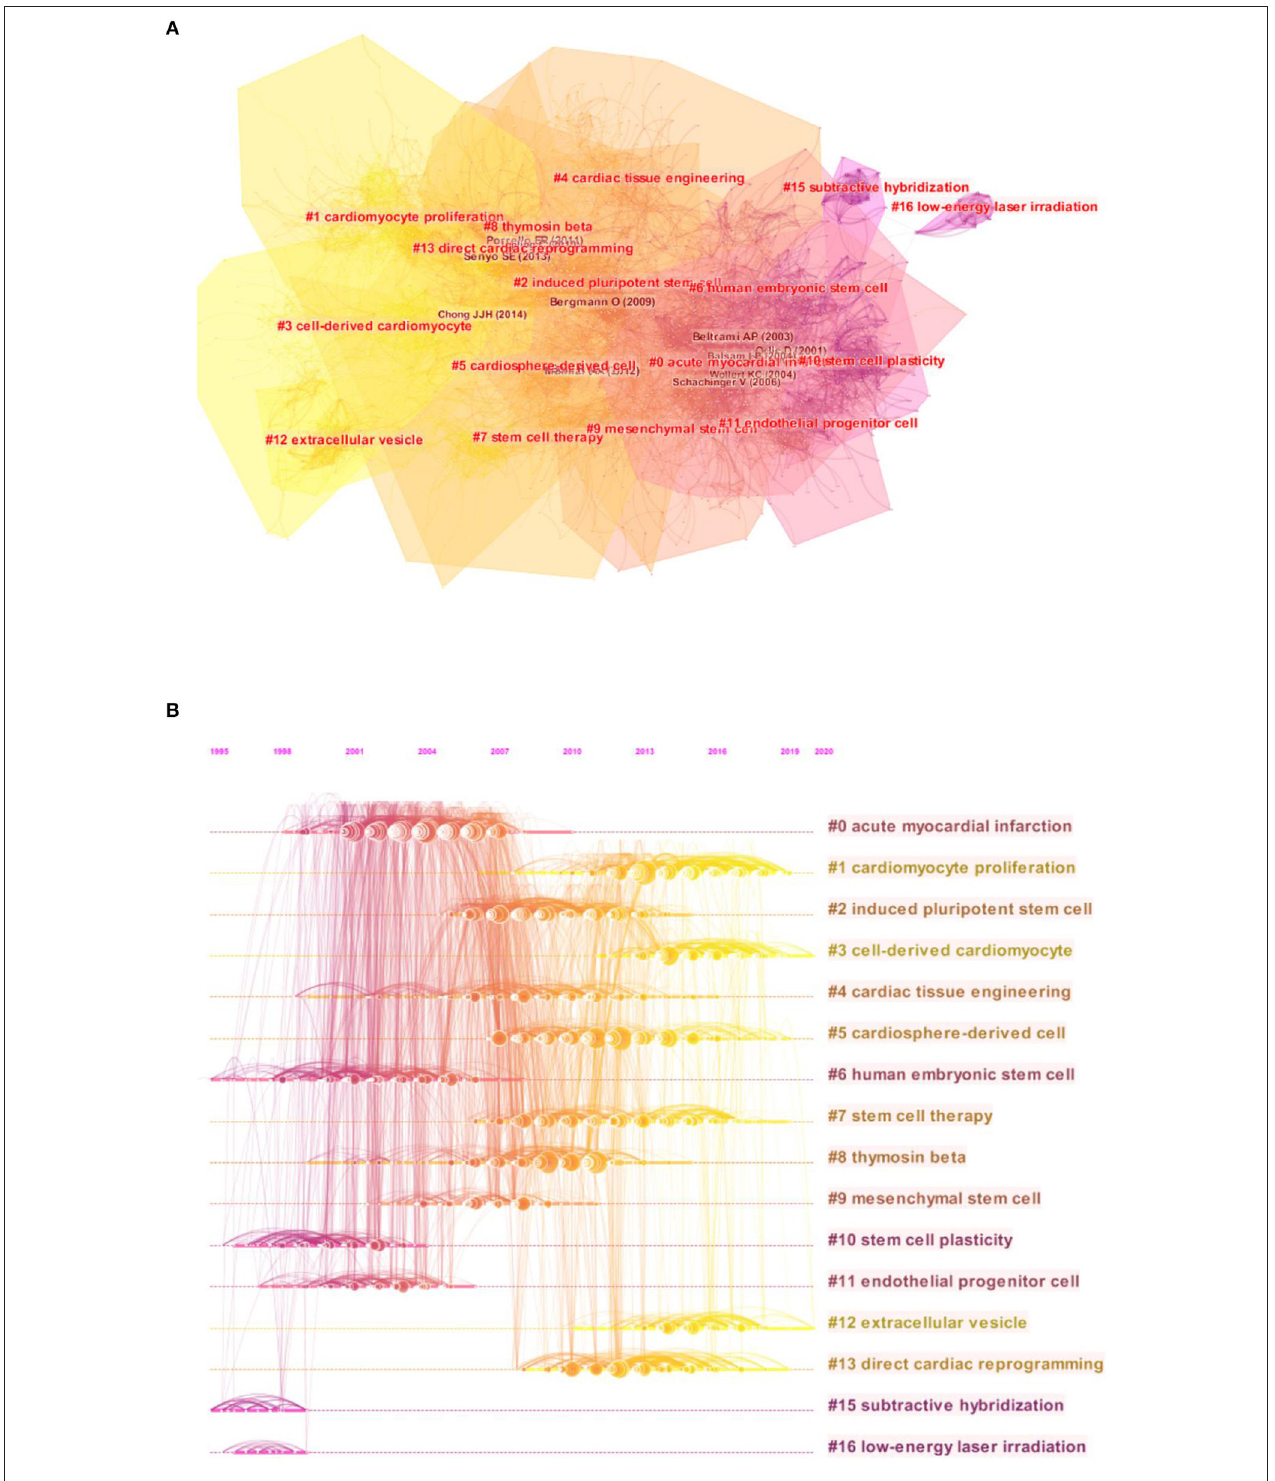
FIGURE 5 | The analysis of co-citation references in the field of cardiac regeneration. (A) The network map of co-citation clusters. Sixteen clusters with different research topics were formed, reflecting in different colors on the map. Cluster #1 cardiomyocyte proliferation, #3 cell-derived cardiomyocyte, #5 cardiosphere-derived cell, #7 stem cell therapy, #12 extracellular vesicle, and #13 direct cardiac reprogramming were the most recent research directions. (B) The timeline view of co-citation clusters. Each horizontal row represented a cluster, and each node presented by a “tree ring” on the line represented a study. The line between the nodes reflected the co-citation relationship between the two studies, and the size of the node meant the number of the co-cited times.